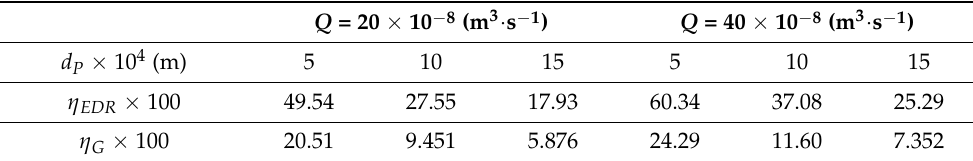
Table 2. Effect of feed flow rate and pellet diameter on external and global effectiveness